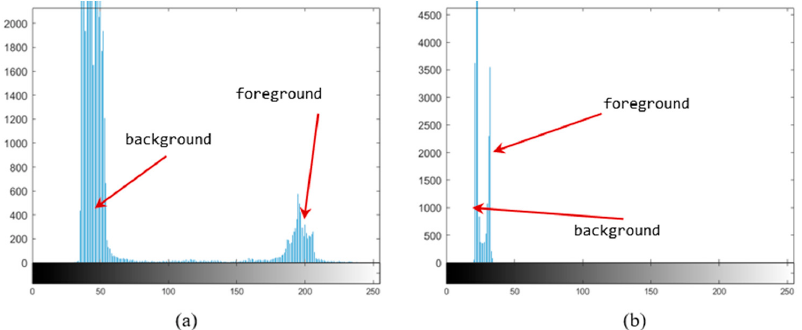
Figure 5. Image grayscale histogram. ( a ) High-contrast image; ( b ) low-contrast image.